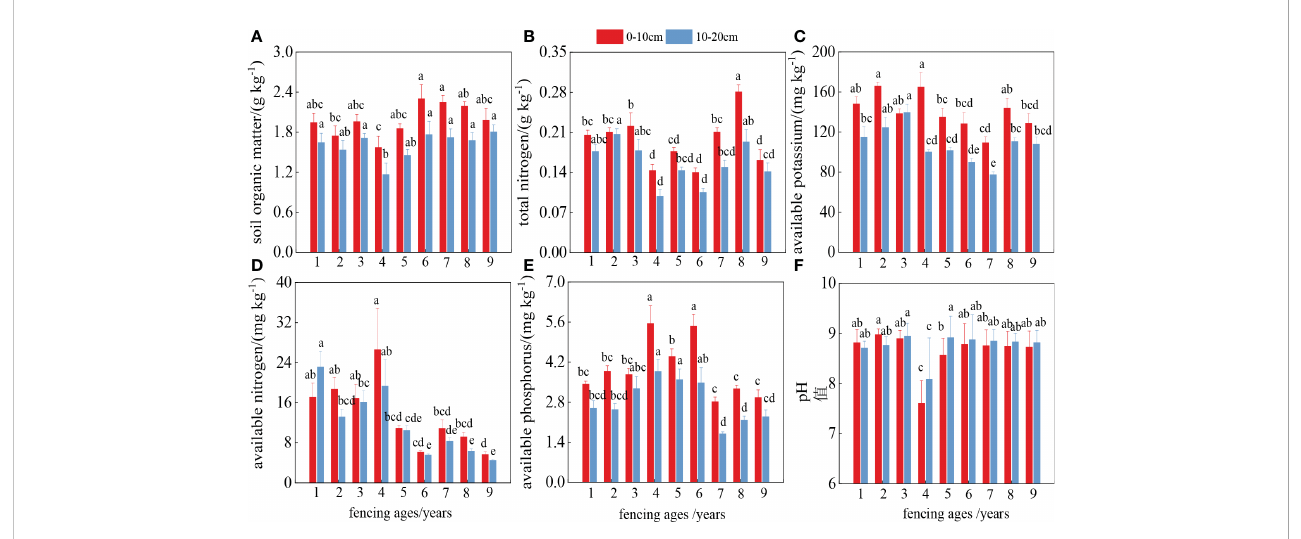
TABLE 3 Results of RDA correspondence analysis between community and environmental factors of Reaumuria soongoric and Nitraria tangutorum . Statistical axis